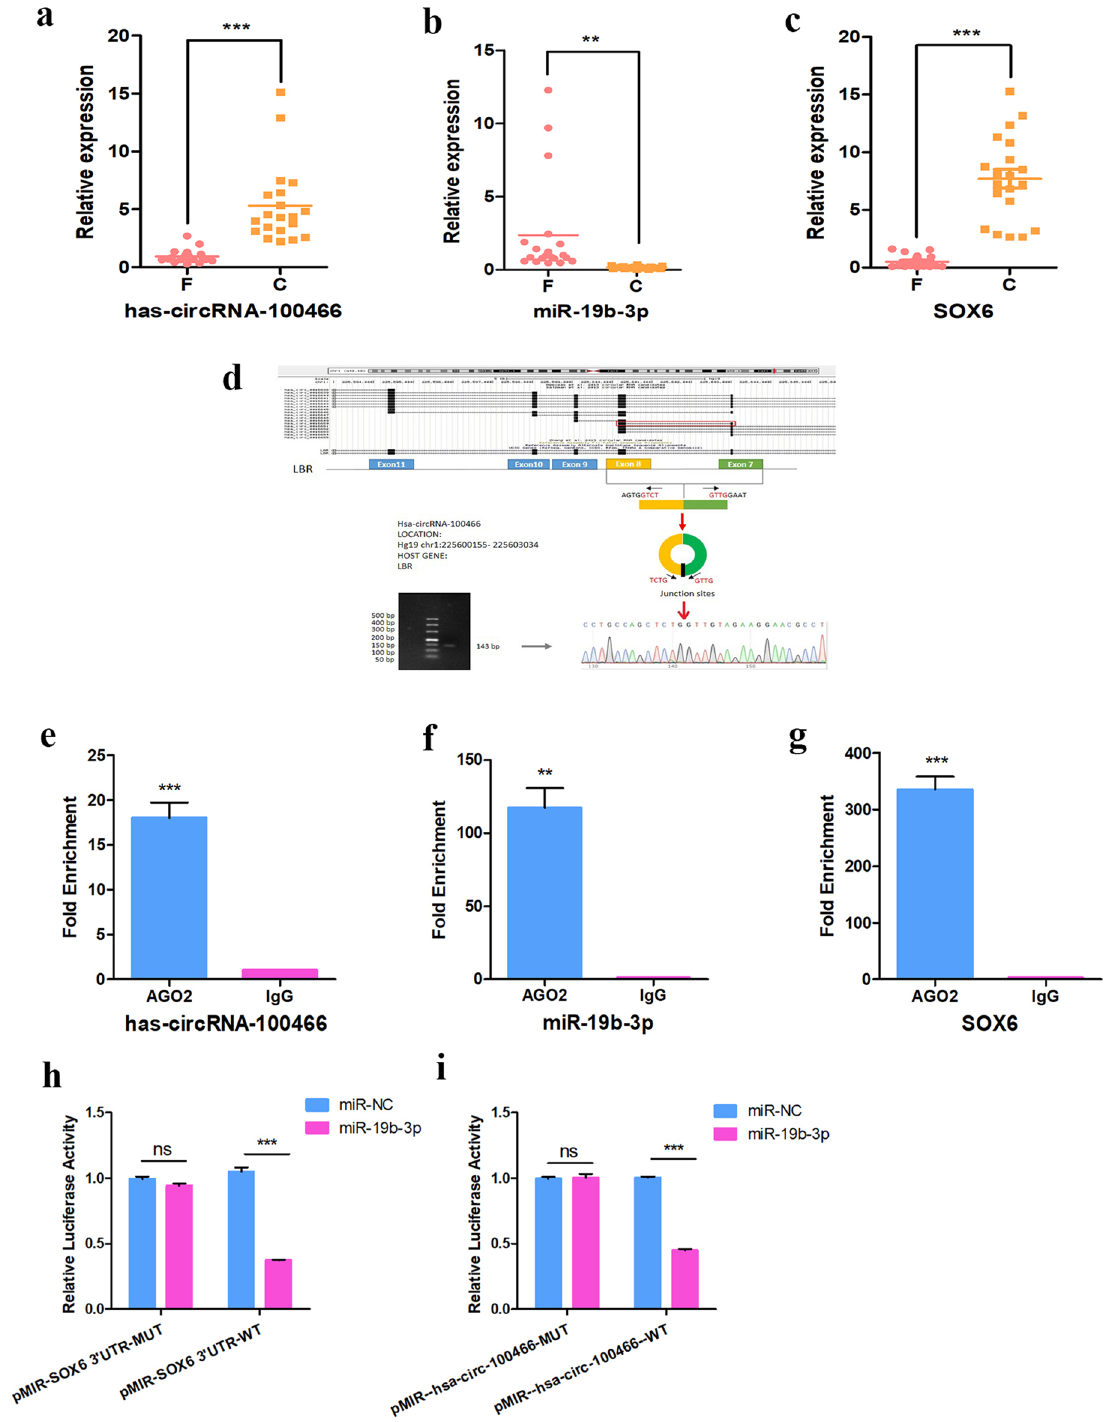
Figure 4. Verification of the ceRNA network by qRT-PCR, RIP, and dual-luciferase reporter assay. The expression levels of hsa-circRNA-100466 ( a ) and SOX6 ( c ) were significantly down-regulated in the F group in comparison with the C group, whereas miR-19b-3p expression levels ( b ) were significantly up-regulated. Schematic diagram showing the location of hsa-circRNA-100466 on chromosome 1:225,600,155–225,603,034 and its derivation from LBR exons 7–8. Agarose gel electrophoresis and Sanger sequencing results of hsa- circRNA-100466 qRT-PCR products ( d ). RIP assay of hsa-circRNA-100466 in K562 cells. Hsa-circRNA-100466 ( e ), miR-19b-3p ( f ), and SOX6 ( g ) were significantly pulled down by the anti-AGO2 antibody. Dual- luciferase reporter assay showing that miR-19b-3p mimics significantly repressed the luciferase activity of hsa-circRNA-100466-WT but not the mutant ( h ). Dual-luciferase reporter assay showing that miR-19b-3p mimics significantly repressed the luciferase activity of SOX6 3’-UTR-WT but not the mutant ( i ). **P < 0.01; ***P <